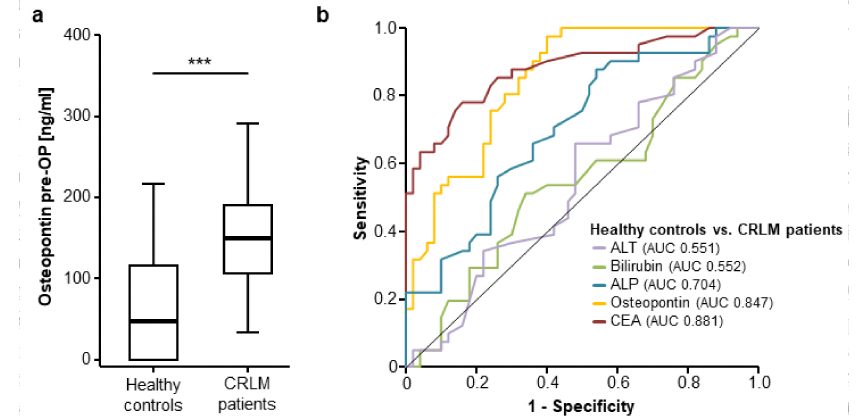
Figure 2. Circulating levels of osteopontin are elevated in patients with CRLM. ( a ) Circulating osteopontin levels are significantly elevated in patients with CRLM compared to healthy controls ( u -test, p (***) < 0.001); ( b ) Osteopontin levels show a similar diagnostic power compared to carcinoembryonic antigen (CEA) serum levels in receiver operating characteristic (ROC) curve analysis, while serum levels of bilirubin, alkaline phosphatase (ALP) and alanine aminotransferase (ALT) are unsuitable for the differentiation between CRLM patients and healthy